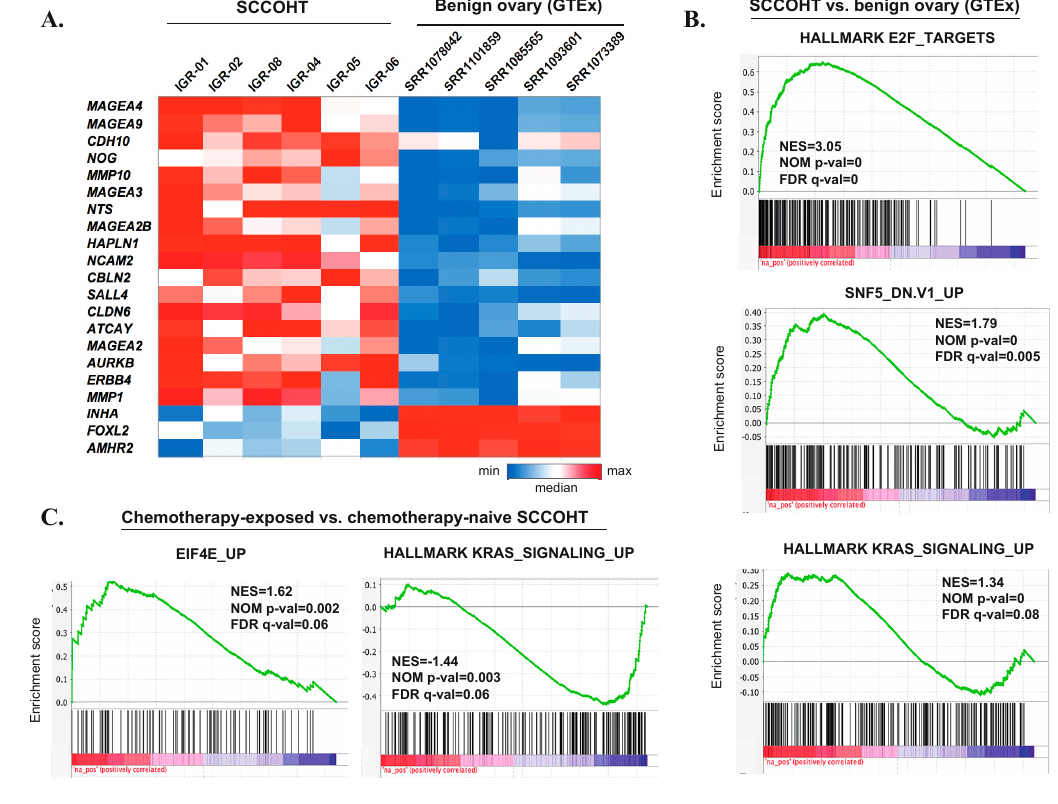
Figure 4. An overview of transcriptomic profiles of SCCOHT. ( A ) Graphic heatmap representation of rank-normalized expression values for selected, most significantly deregulated genes in the differential expression analysis between SCCOHT and benign ovarian tissue (GTEx). ( B ) Selected GSEA results for the differential expression analysis between SCCOHT and benign ovarian tissue (GTEx). ( C ) Selected GSEA results for the differential expression analysis between chemotherapy-exposed SCCOHT samples (IGR-01, IGR-04, IGR-06) and chemotherapy-naïve samples (IGR-02, IGR-05, IGR-08).